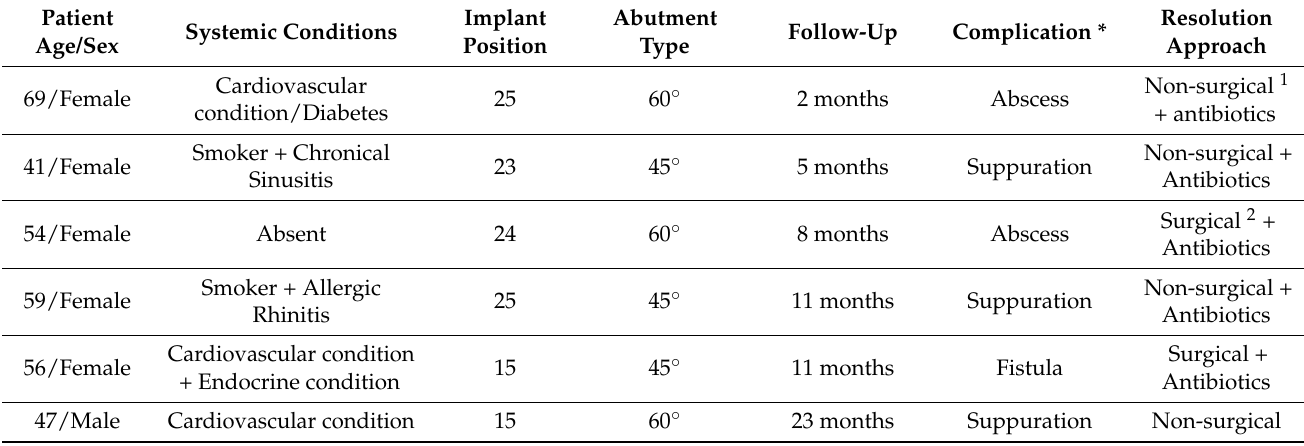
Table 4. Biological complications occurred during the study follow-up and resolution approaches.